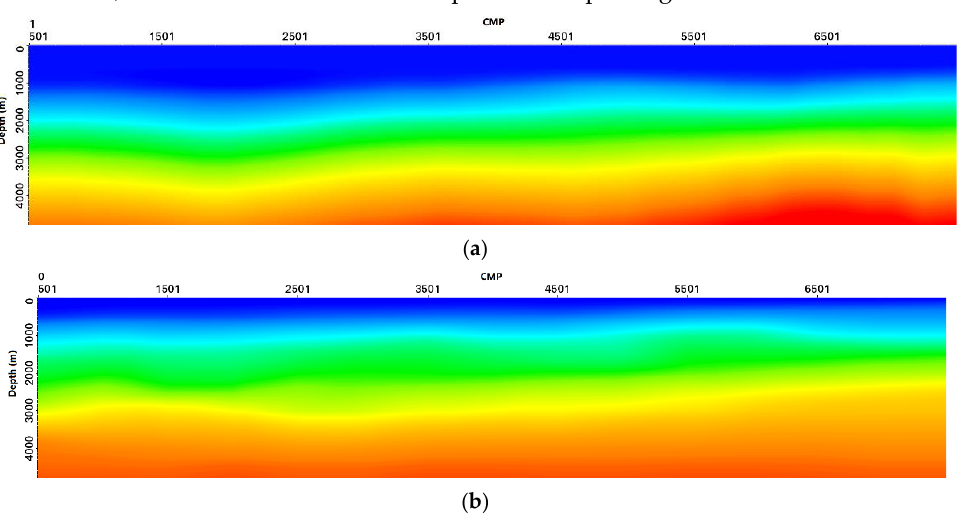
Figure 6. ( a ) The depth domain velocity model of the P-wave with a velocity model building workflow including layer- and grid-based tomography. ( b ) The corresponding depth domain velocity model of the SH shear wave.